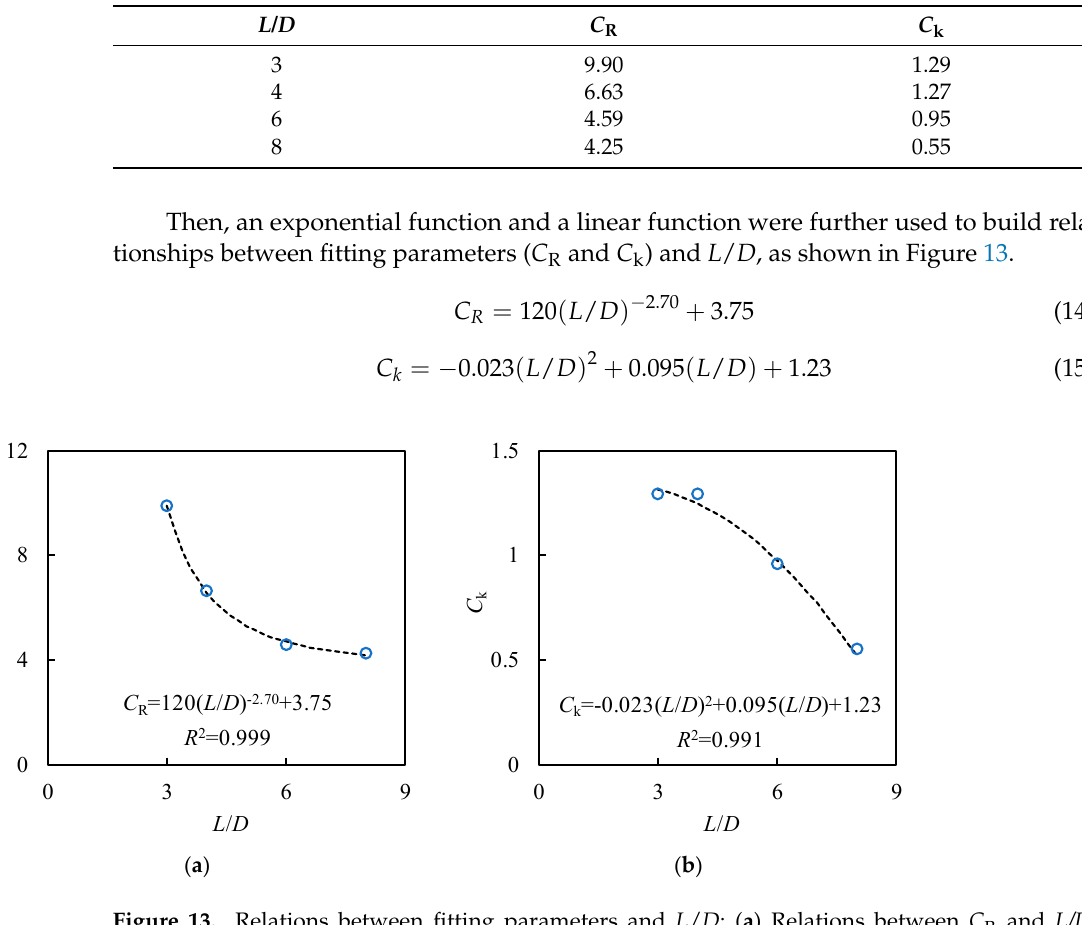
Table 6. Fitting parameters for piles with various diameters.